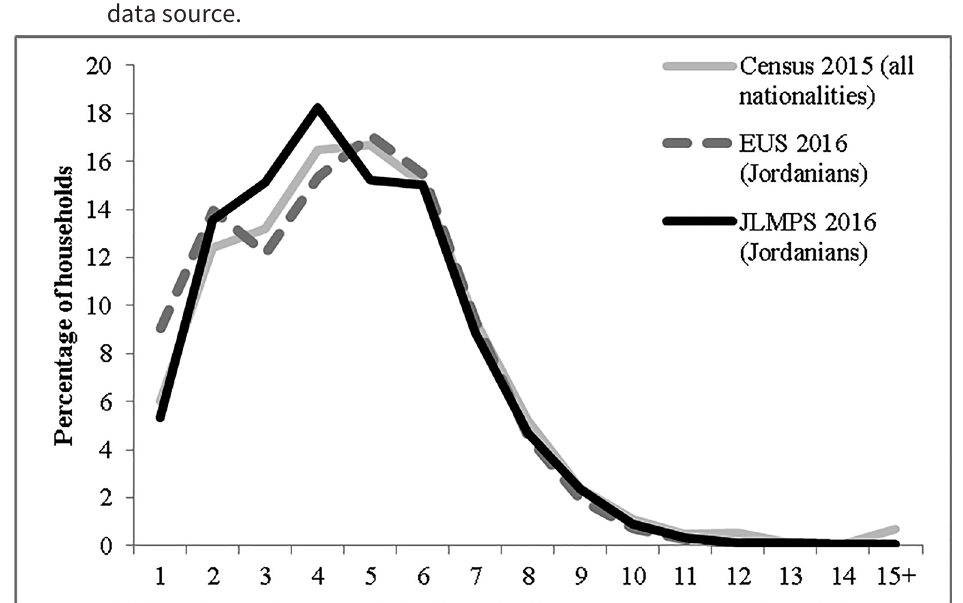
Figure 4 Comparison of household size (percentage of households), Jordanians (EUS and JLMPS), all nationalities in private households (Census), by 2015/2016 data source.